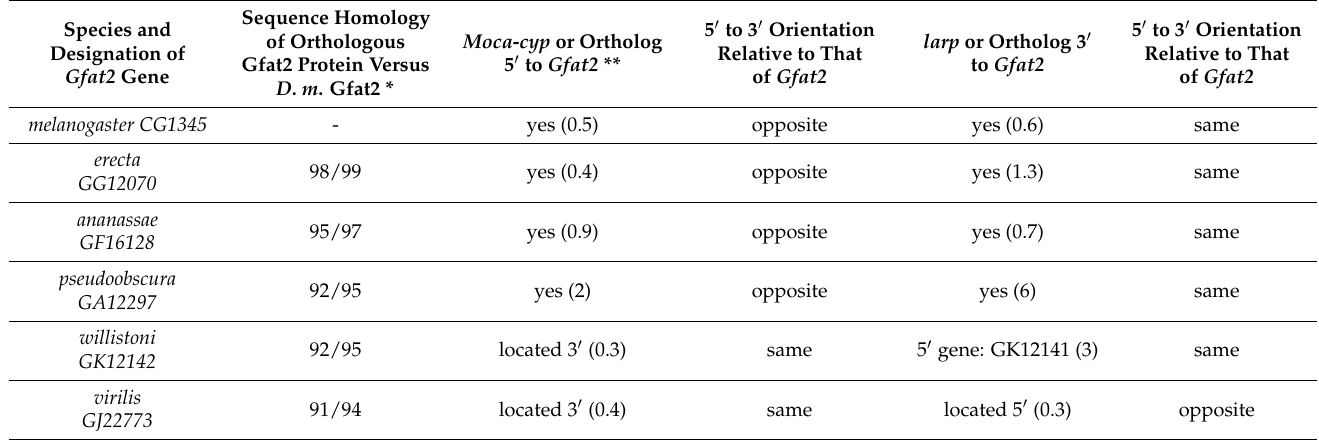
Table 7. Microsynteny of two genes flanking Gfat2 or its ortholog in six Drosophila